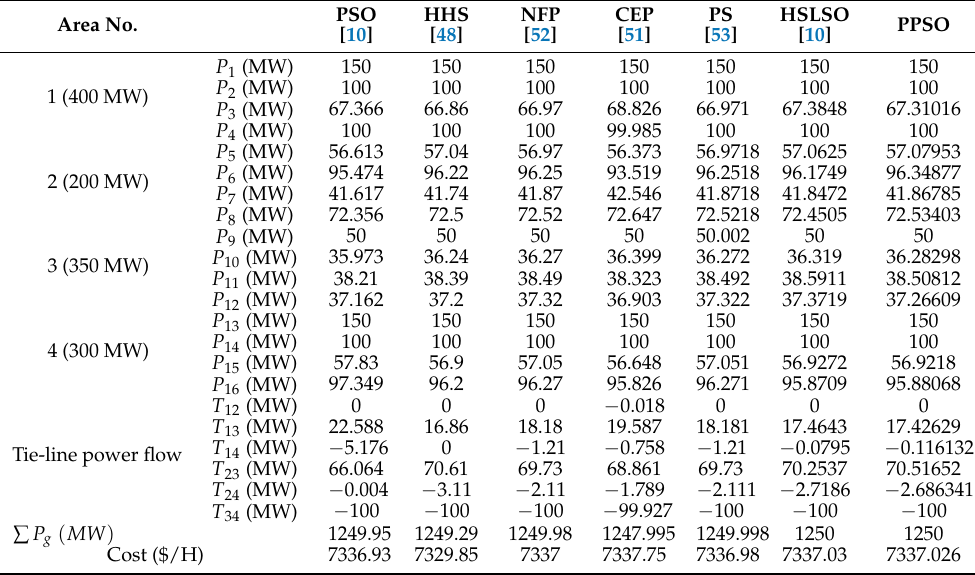
Table 2. The best solutions obtained for the medium-scale test system. Area No.